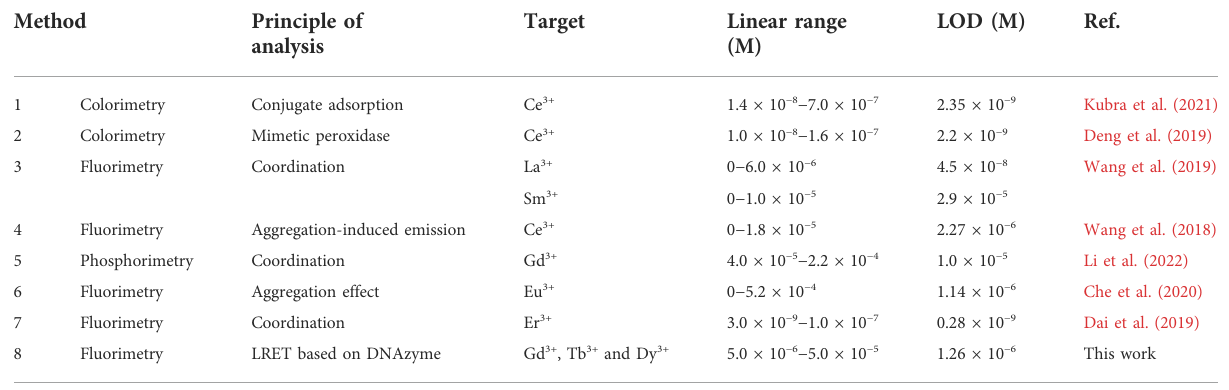
TABLE 1 Comparison of the different methods for the detection of rare-earth ions.